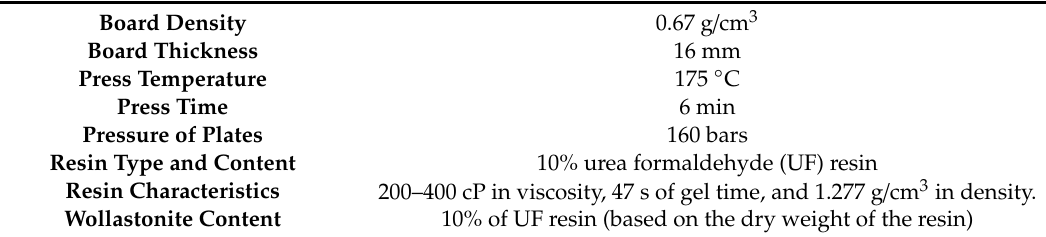
Table 1. Board manufacture